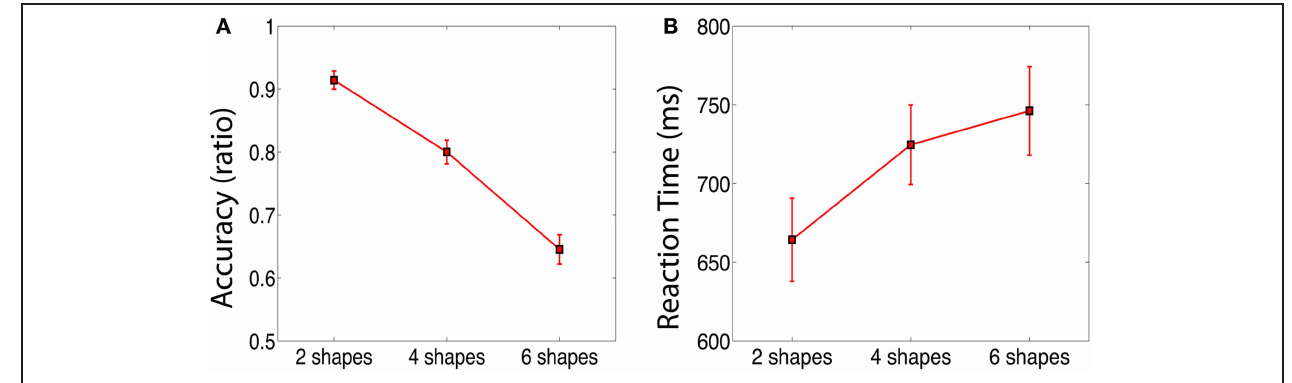
FIGURE 2 | Plot of behavioral results. (A) Accuracy, representing the proportion of correct answers as a function of the number of shapes in the stimuli. (B) Reaction-time as a function of the number of shapes in the